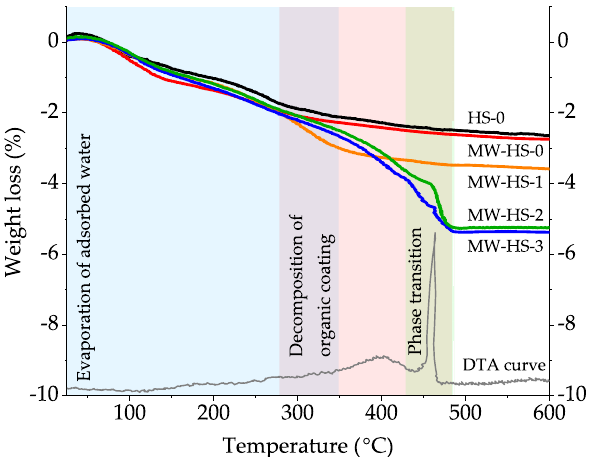
14 Figure 4. Thermogravimetric curves for the obtained samples and a representative DTA curve of the MW-HS-3